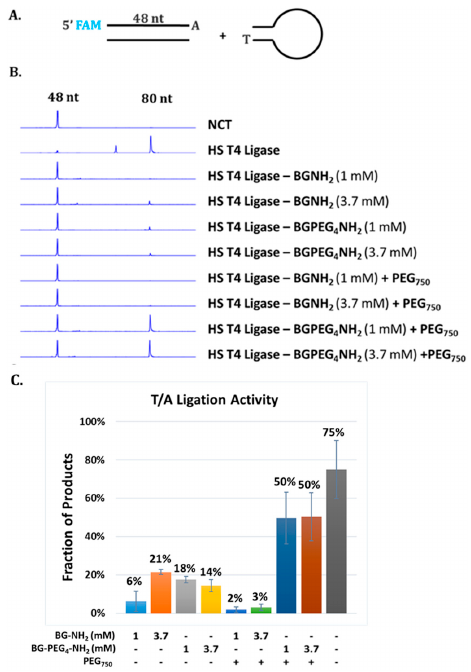
Figure 5. Optimization of activity of immobilized T4 DNA ligase by PEG spacer and coating. SNAP- tagged T4 DNA ligase was immobilized to magnetic beads loaded with 1 mM or 3.7 mM BG ligand with or without PEG 4 spacer and PEG 750 coating. ( A ) Ligase activity was evaluated by ligation of two synthetic duplex DNA substrates possessing a single 3 ′ A and 3 ′ T overhang, respectively. The reactions were carried out by incubation of 100 nM of synthetic substrates and 200 nM enzyme in 1× Blunt/TA buffer (NEB) at 20 °C for 15 min. A 49-nt oligomer with a 3 ′ A overhang and a 5 ′ FAM probe was used to monitor ligation by CE analysis. ( B ) Representative CE data showing an increase of 80- nt product catalyzed by T4 DNA ligase immobilized to PEG 750 coated and PEG 4 spaced beads. ( C ) Quantitative analysis of CE data showing efficiency of product formation in each combination of chemical modifications.